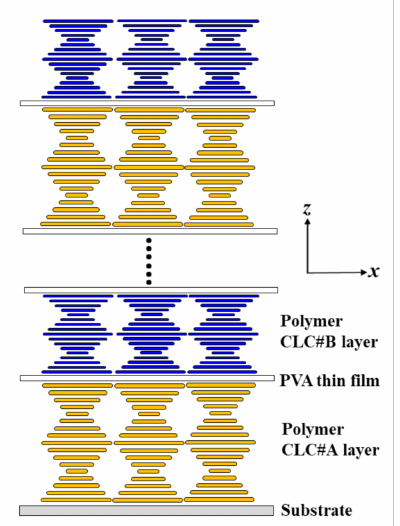
Figure 9. Schematic of fabrication by repeated sequentially stacking alternate polymer layer of CLC#A, poly(vinylalcohol) (PVA) thin film, polymer layer of CLC#B, and PVA thin film. PVA thin films may be replaced by PA thin films